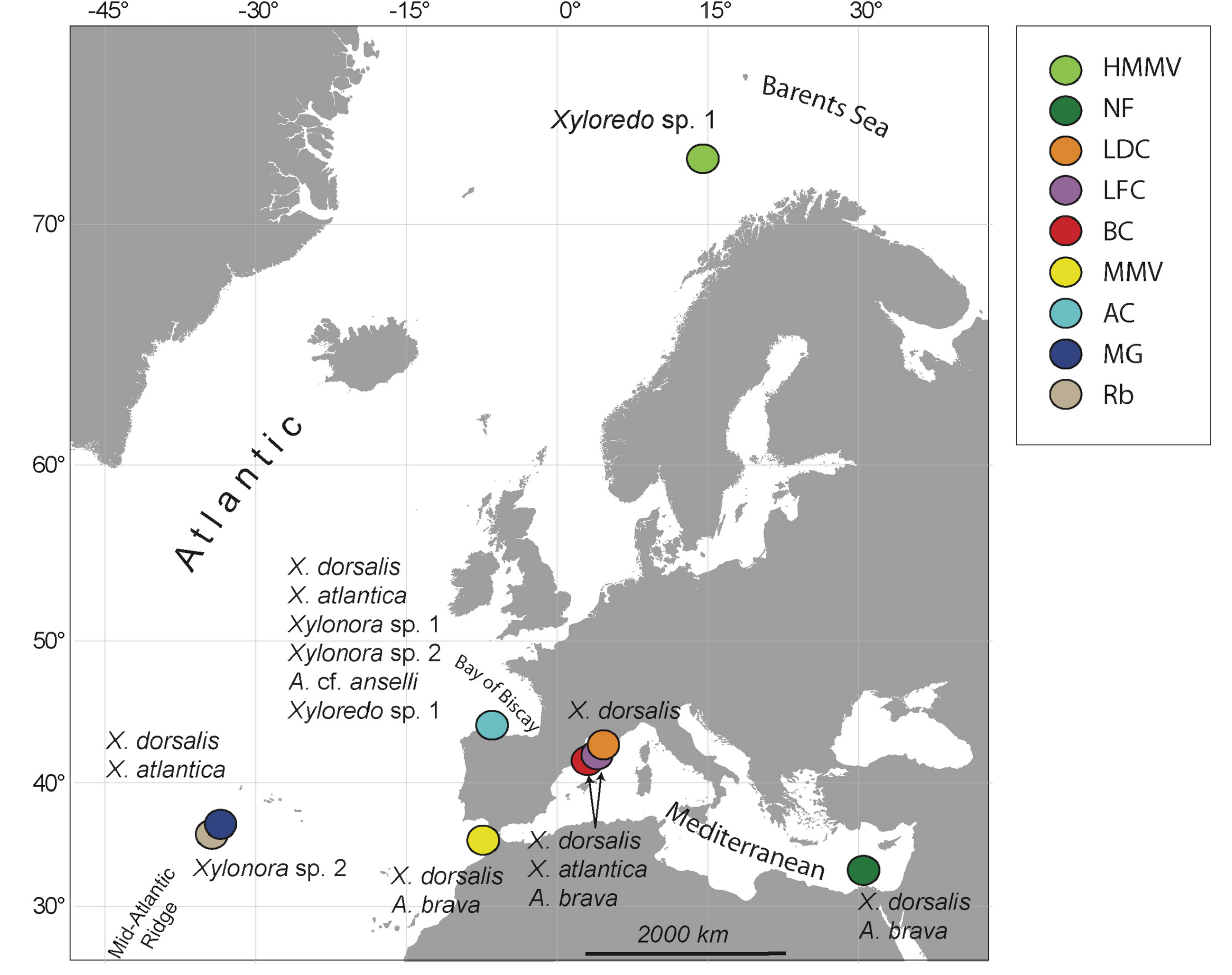
( Supplementary Table S3 ). All sequences were aligned